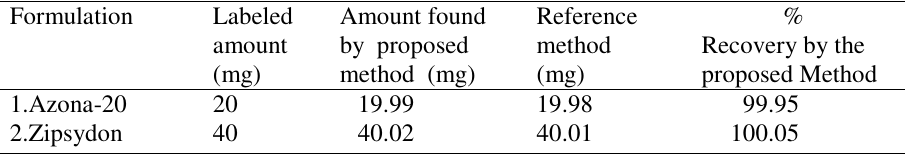
Table 2 . Assay of Ziprasidone in Pharmaceutical